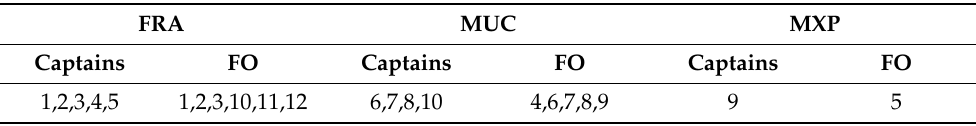
Table 5. Initial placement of pilots.